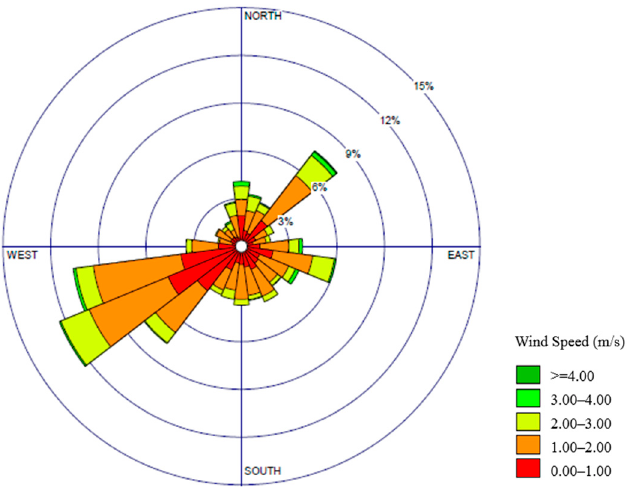
Figure 2. Wind rose diagram in the atmospheric vertical altitude of 10 m at the WWTP during 2017. Legend denotes wind speed categories and their associated colors. WWTP: Municipal wastewater treatment plant.